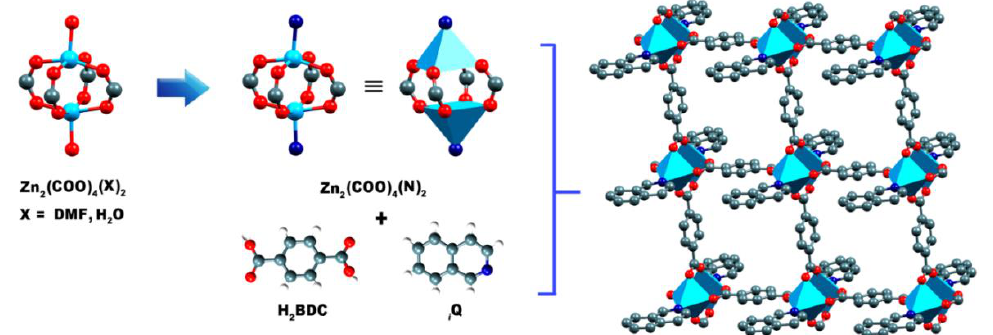
Figure 1. Asymmetric unit of 1 .